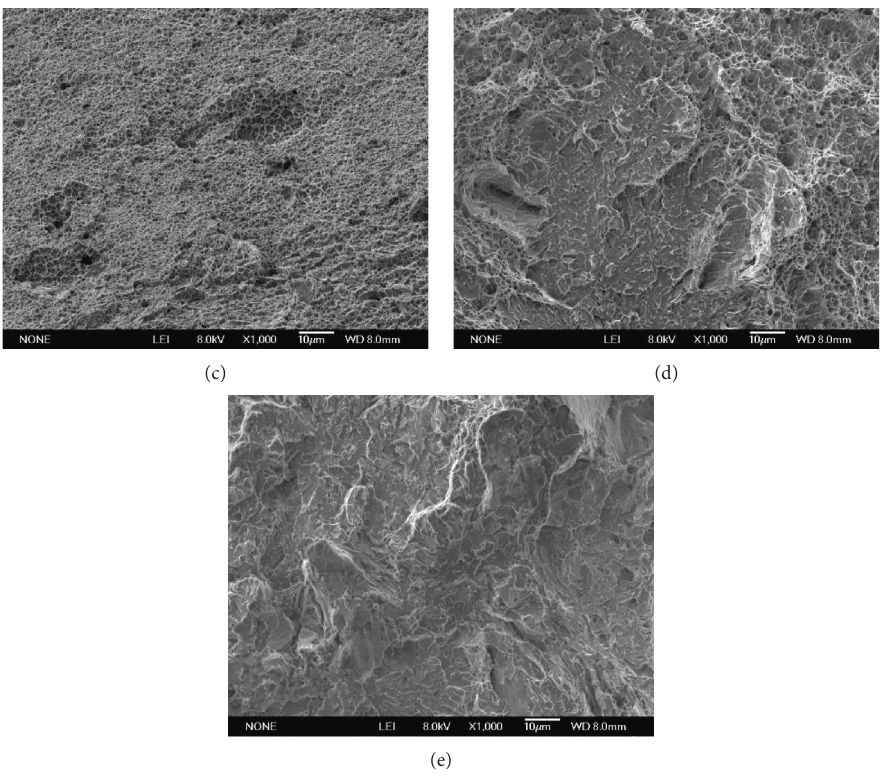
Figure 9: The micromorphology of the impact fracture at different temperatures in the center of the weld. (a–c) Ductile fracture morphology and (d, e) brittle fracture morphology. (a) 20 ° C, (b) − 20 ° C, (c) − 40 ° C, 60 ° C, (d) − 40 ° C, and (e) − 60 ° C.